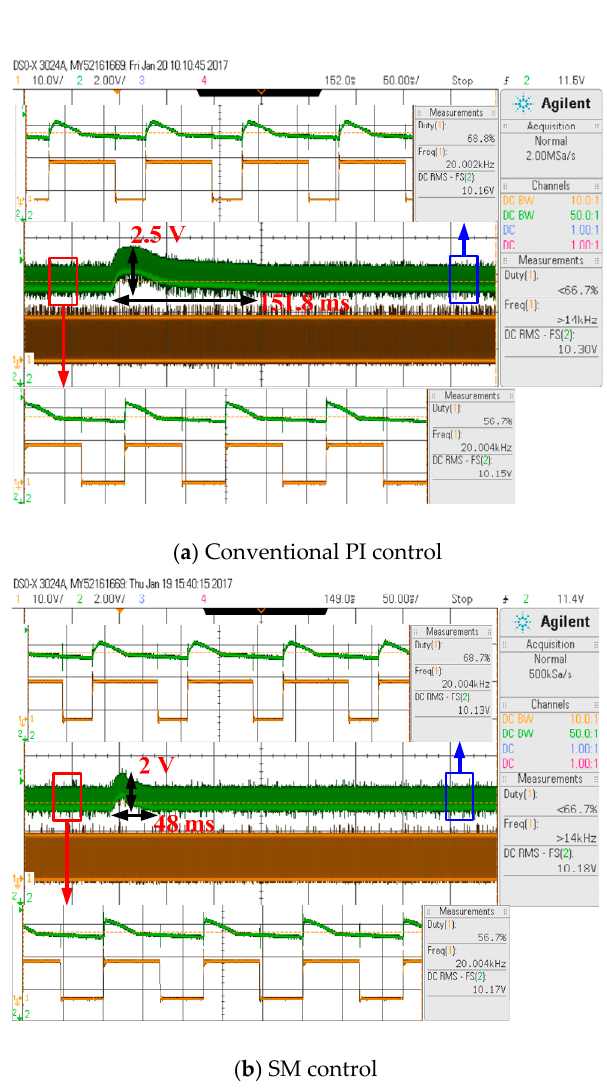
Figure 8. The waveforms of V out and the switching signals when the phase displacement is altered from 120° to 100°.